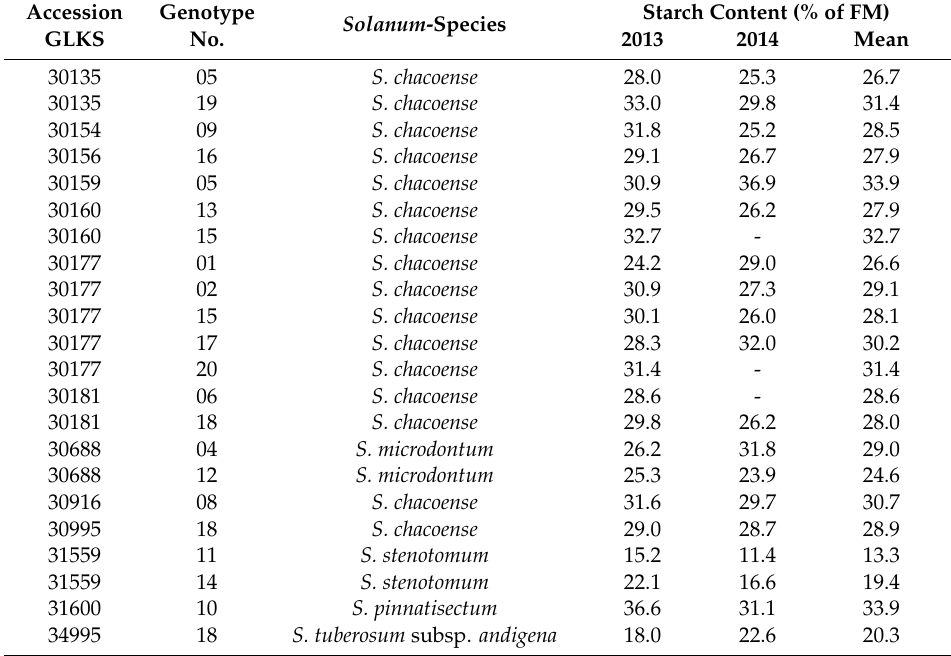
Table 2. Selected accessions and genotypes of the Gross Luesewitz Potato Collections used for the N e ffi ciency experiments as well as their respective tuber starch contents (%) in 2013 and